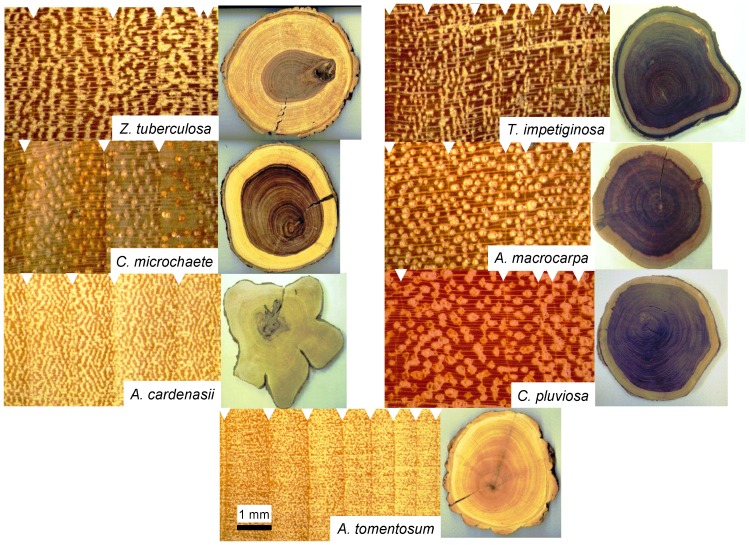
Wood cross-sections with distinct annual rings of studied tree species.The white triangles mark the annual boundaries corresponding to marginal parenchyma. In the rings the growth direction is from left (pith) to right (bark).